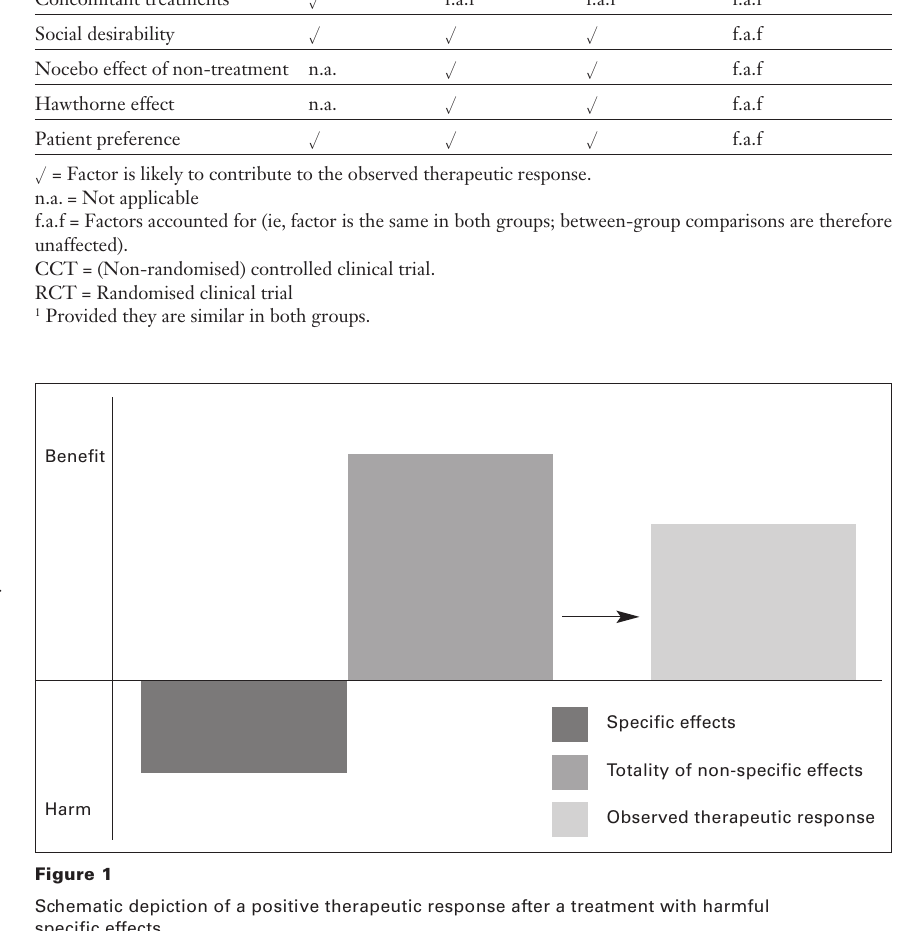
Potential non-specific contributors to an observed therapeutic effect in various study types. Situation Uncontrolled CCT RCT Contributing factor